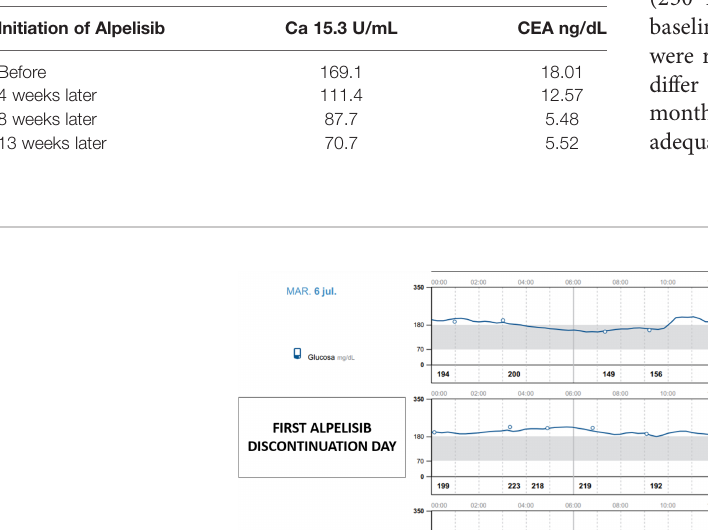
TABLE 1 | Alpelisib impact in tumor markers evolution.